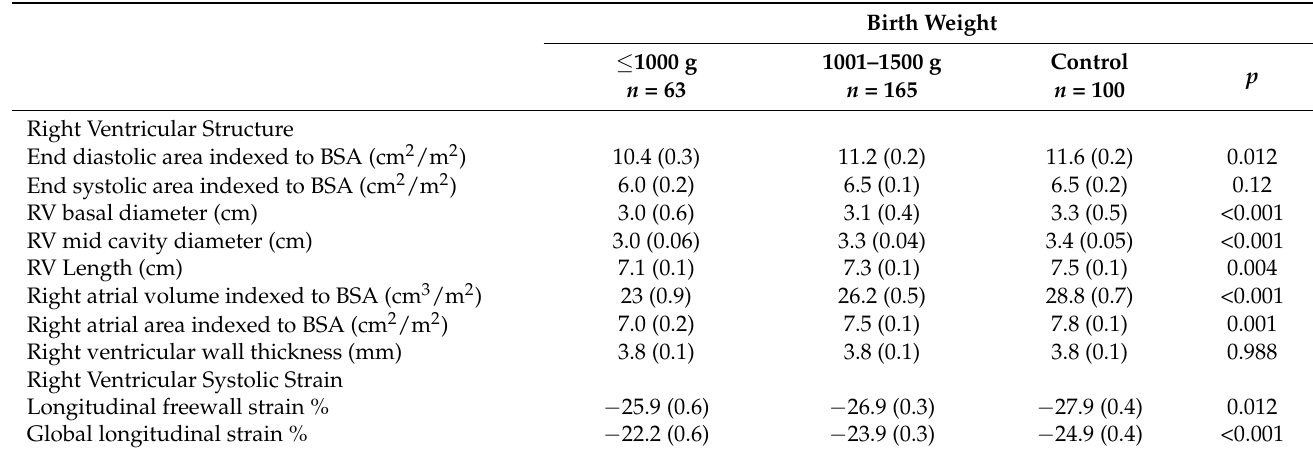
Figure 1. RV freewall strain is associated with gestational age. Right ventricular freewall longitudinal strain compared between gestational age groups corresponding to extremely preterm (<28 weeks), very preterm (28–31 weeks), and moderately to late preterm (32–36 weeks), controls are all term- born [29]. Diamonds indicate the sex-adjusted mean. Bars indicate the standard error. Table 4. RV structural and strain indices compared by birth